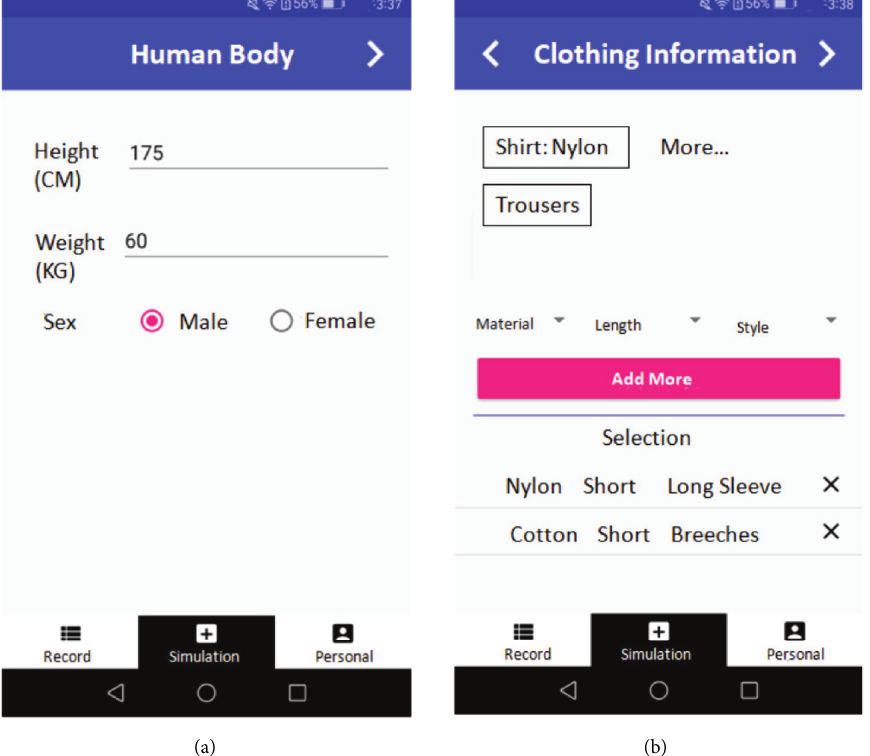
Figure 6: Client interface for inputting simulation parameters. (a) Human setting interface. (b) Clothing setting interface.